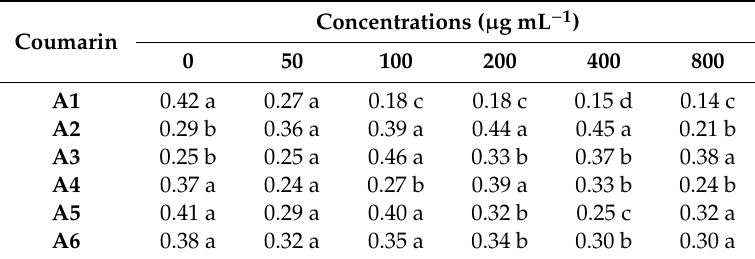
Table 3. Averages obtained for fresh biomass of Lactuca sativa seedlings exposed to the six eugenol- derived coumarins.